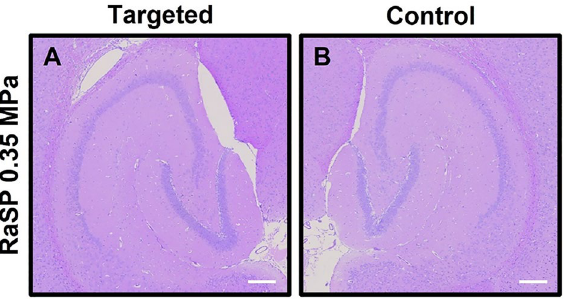
Figure 6. No tissue damage by RaSP at 0.35 MPa. H&E-stained 6-μm-thick paraffin-embedded horizontal brain slices showed no red blood cell extravasation or microvacuolations caused by RaSP emitted at 0.35 MPa 33 . Scale bars are 200